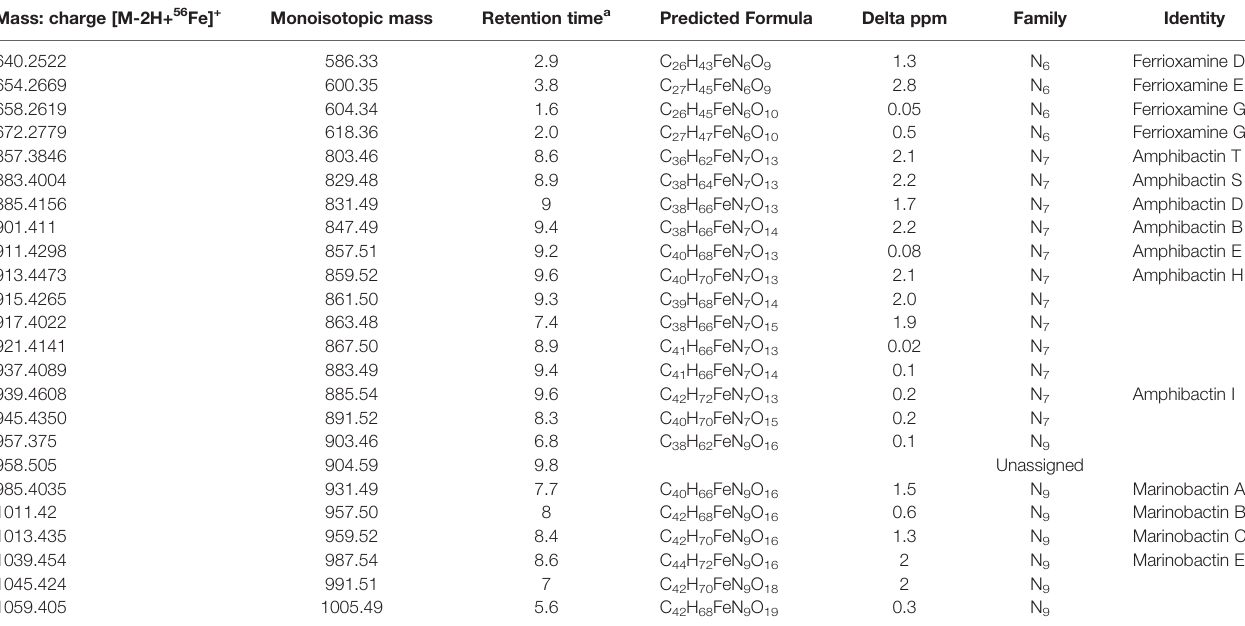
TABLE 1 | Masses ([M+ 56 Fe+H] + ) of siderophores identi fi ed in shelf waters of the Celtic Sea. Mass: charge [M-2H+ 56 Fe]